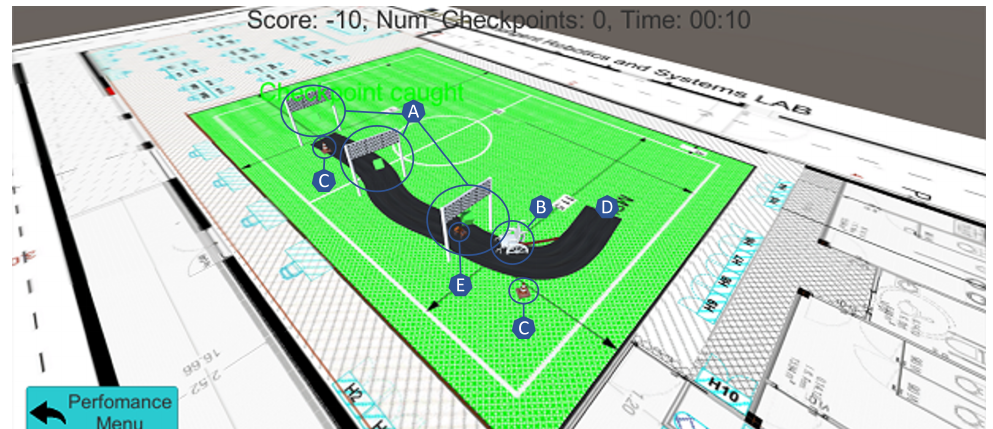
Figure 3. Visualization tool for revisiting the participant’s experiences and performances. The tool receives multiple variables from the smartphone attached to the robotic wheelchair, which enables the creation of a virtual representation/simulation of the ARSG. Overview: A—passage points; B— intelligible wheelchair model representing the robotic wheelchair location; C—obstacles; D—starting position; E—moving